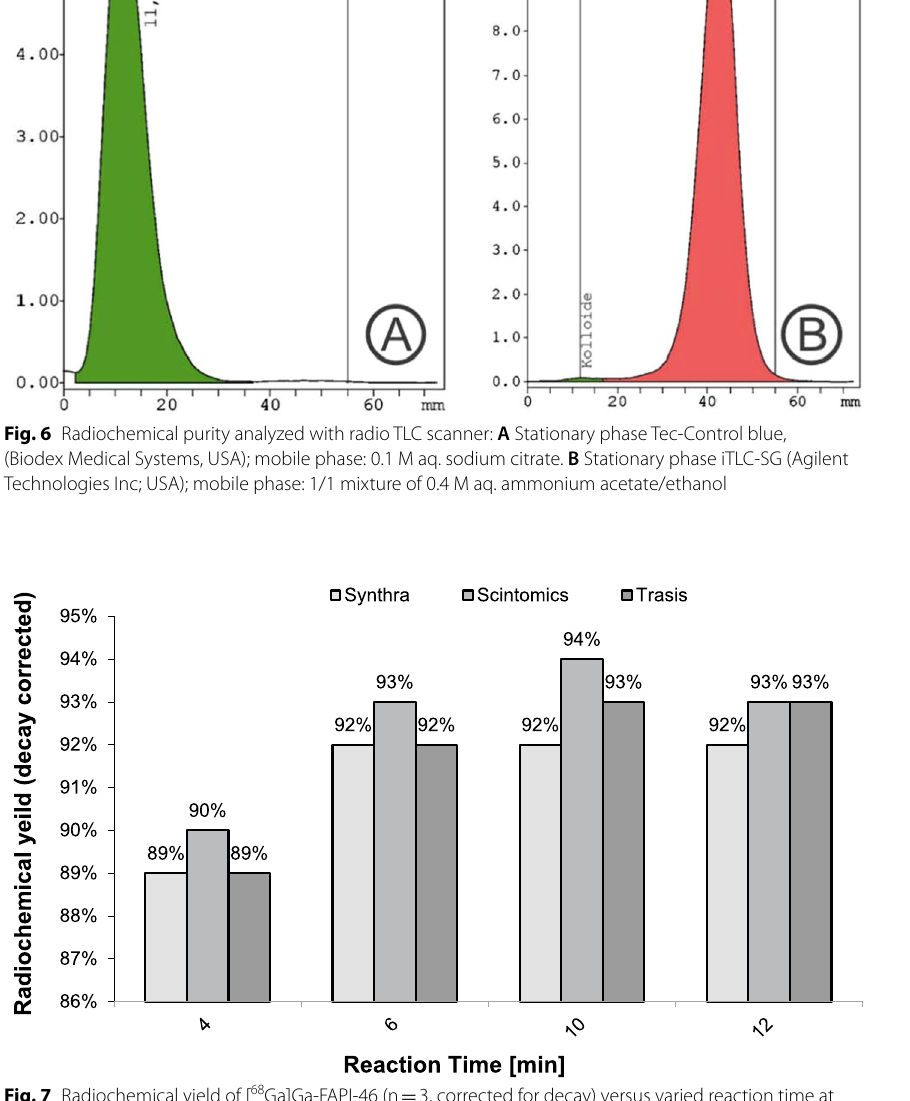
3, corrected for decay) versus varied reaction time at =